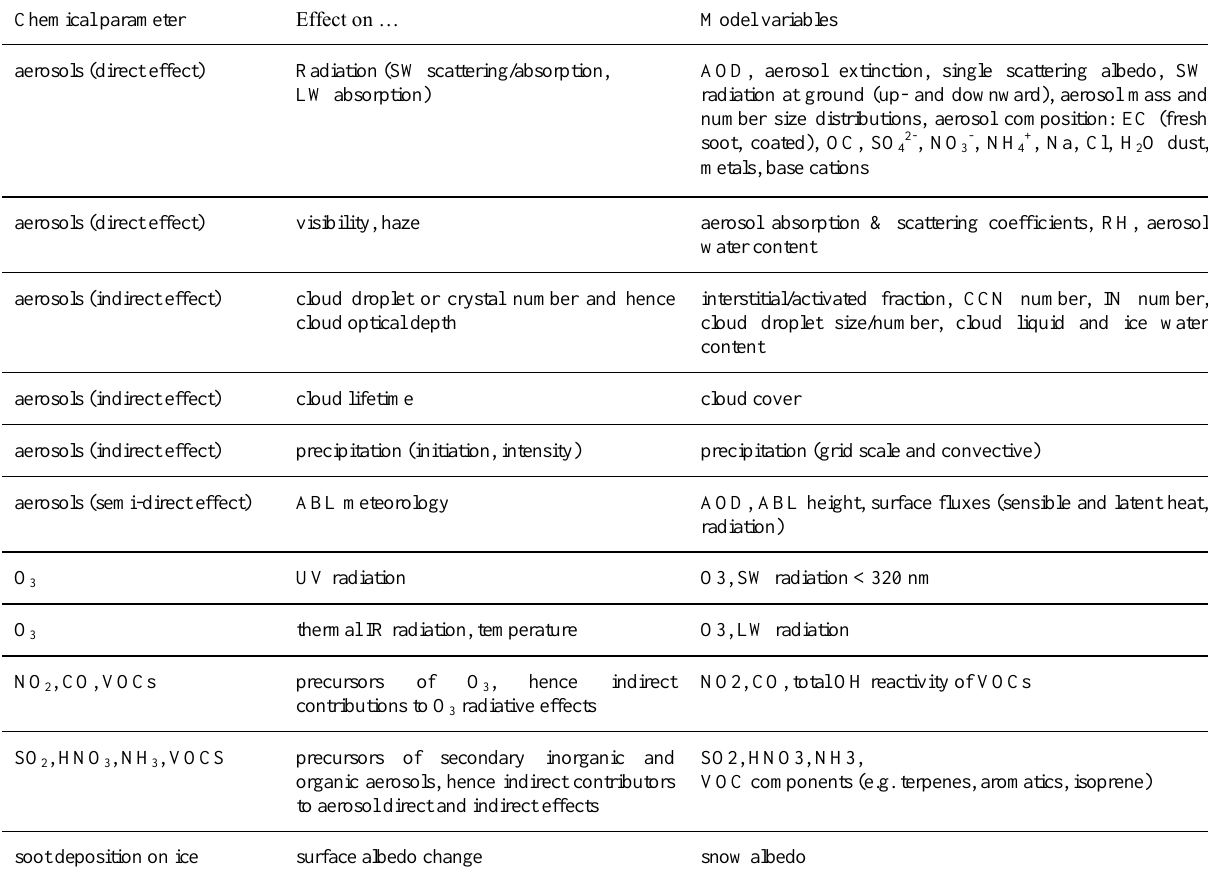
Table B2. List of effects of chemistry on meteorology.